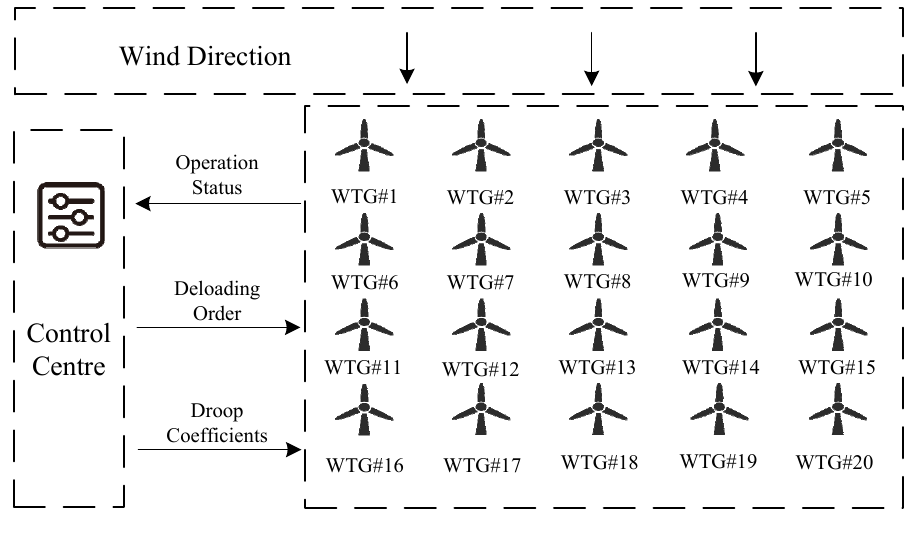
Figure 10. Structure of the wind farm.